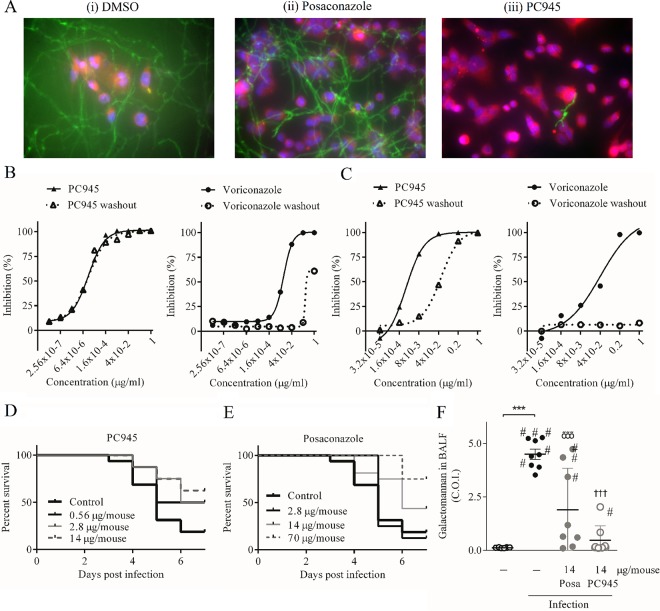
Antifungal activity of PC945 against A. fumigatus
in vitro and in vivo. (A) A549 cells treated with PC945 or posaconazole and infected with GFP-expressing A. fumigatus. Green, GFP-expressing A. fumigatus; blue, DAPI-stained nucleus; red, CellTracker-stained cytoplasm. (B) Persistence of action of PC945 and voriconazole on A. fumigatus hyphae. (C) Persistence of action of PC945 and voriconazole on human bronchial cells (BEAS2B cells) infected with A. fumigatus. (D and E) Effects of once-daily intranasal treatment with PC945 (0.56, 2.8, or 14 μg/mouse) and posaconazole (2.8, 14, or 70 μg/mouse) on survival of A. fumigatus-infected immunocompromised mice (n = 8 to 16). (F) Galactomannan levels in BALF. Each horizontal bar shows the mean ± SEM for 8 mice per group. #, dead before day 7; ***, significant difference from no infection (P < 0.001); †††, significant difference from infection control (P < 0.001).